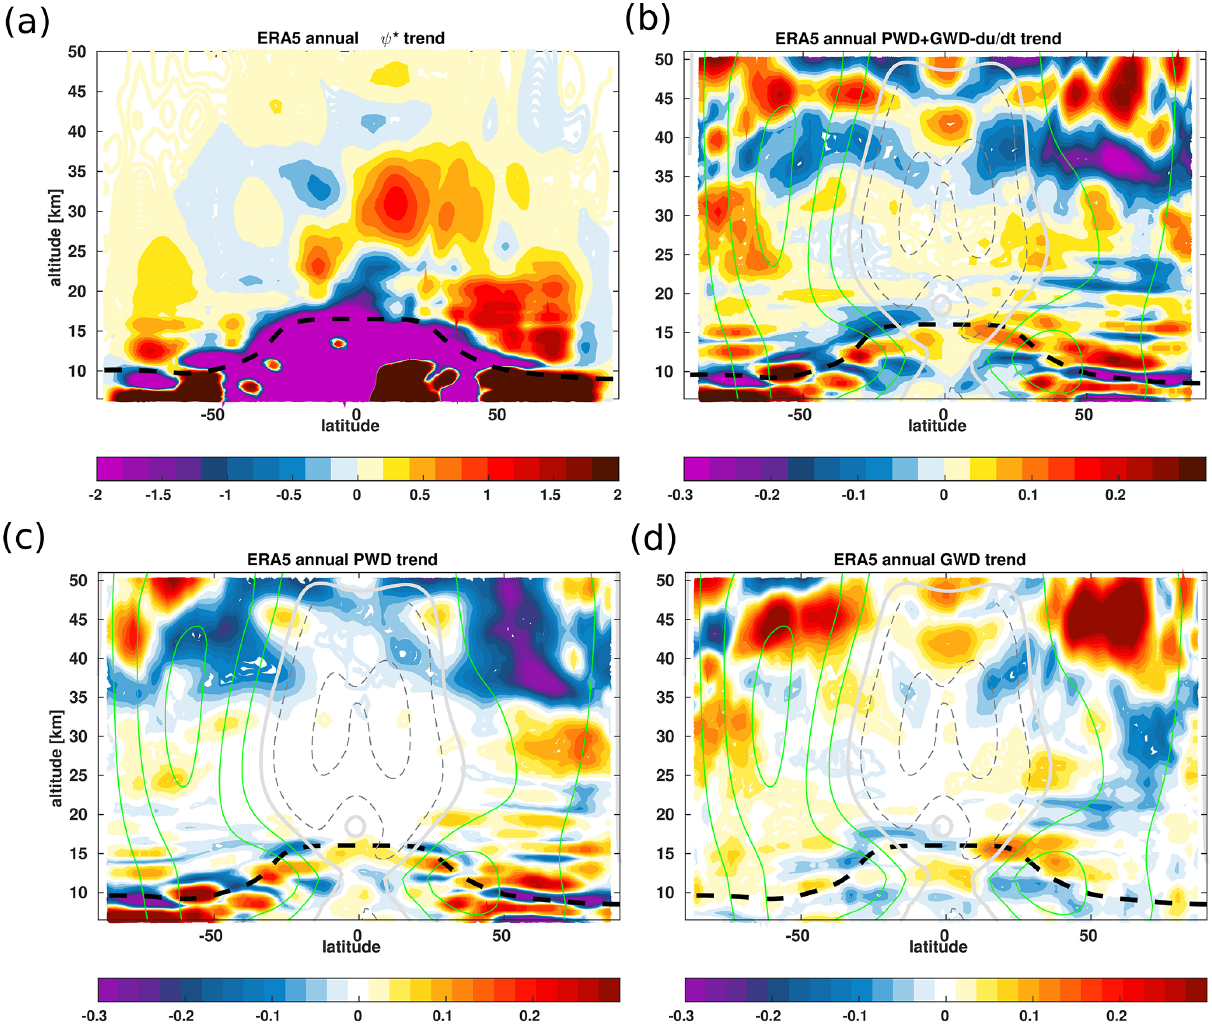
Figure 12. Linear trends of the ψ ∗ (a) , net wave forcing (b) , planetary wave drag (c) , and gravity wave drag (d) from the ERA5 reanalysis for the 1979–2018 time period. The units of the ψ ∗ trend and wave drag trend are in m − 2 s − 1 decade − 1 and ms − 1 d − 1 decade − 1 , respectively. Trends are statistically significant at 95% estimated using Student’s t test. The climatological tropopause from the ERA-Interim is indicated as the dashed black horizontal line. The thick white line indicates the zero-line zonal mean wind. The thin green and grey lines indicate the climatological zonal mean